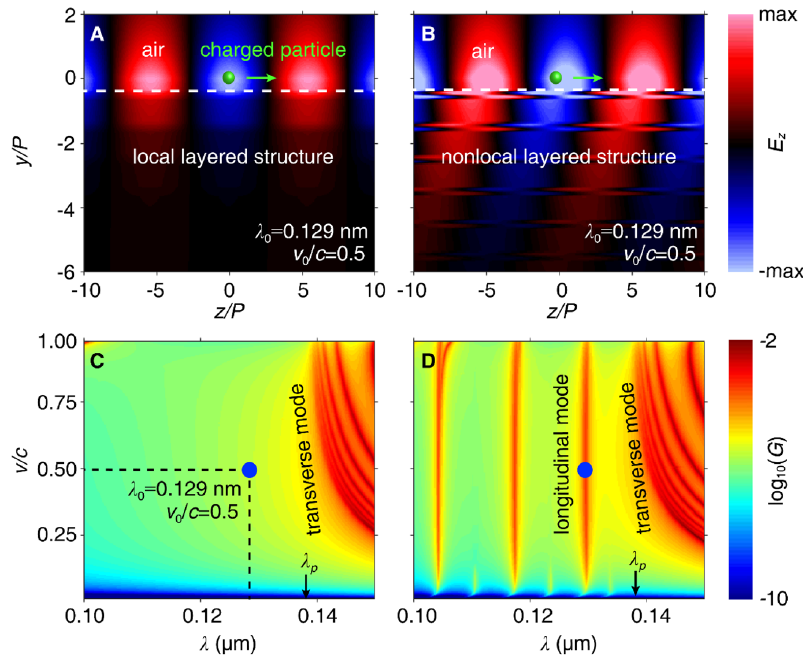
Figure 2: Photon emission enhanced by longitudinal plasmon modes. (A) and (B)